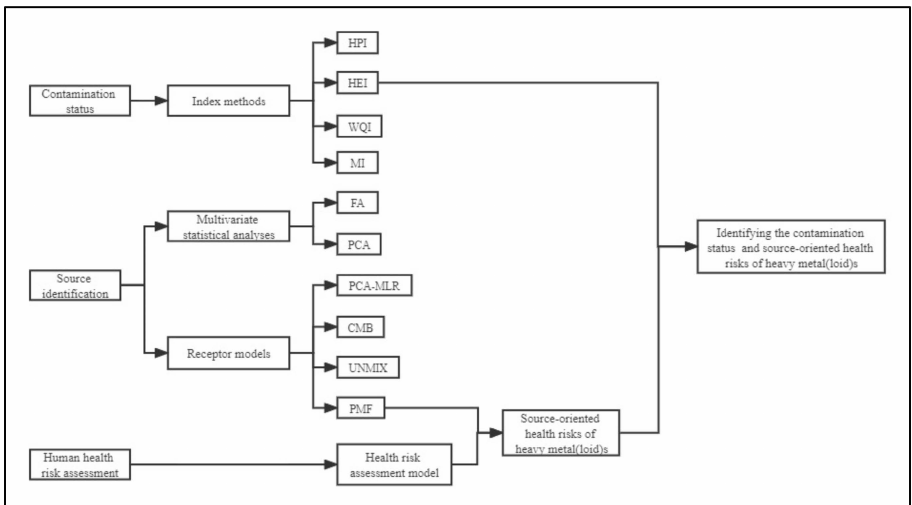
Figure 1. Research Methods and